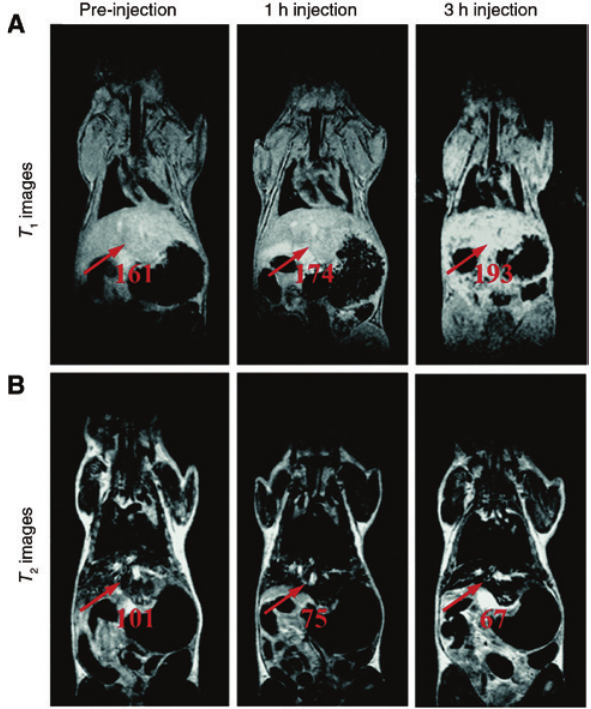
Figure 18: (A) T1-weighted and (B) T2-weighted in vivo coronal MRI images of a healthy mouse before injection as well as at 1 and 3 h after the intravenous injection of BaGdF :50 mol % Er NPs into the 5 tail vein. The arrows indicate the liver locations with contrast-enhancing effects, and the numbers below are the corresponding average signal intensities. These in vivo MRI images were acquired by a 1.0 T MRI system. Taken from [313]. Reproduced with permission of The Royal Society of Chemistry. Copyright ©